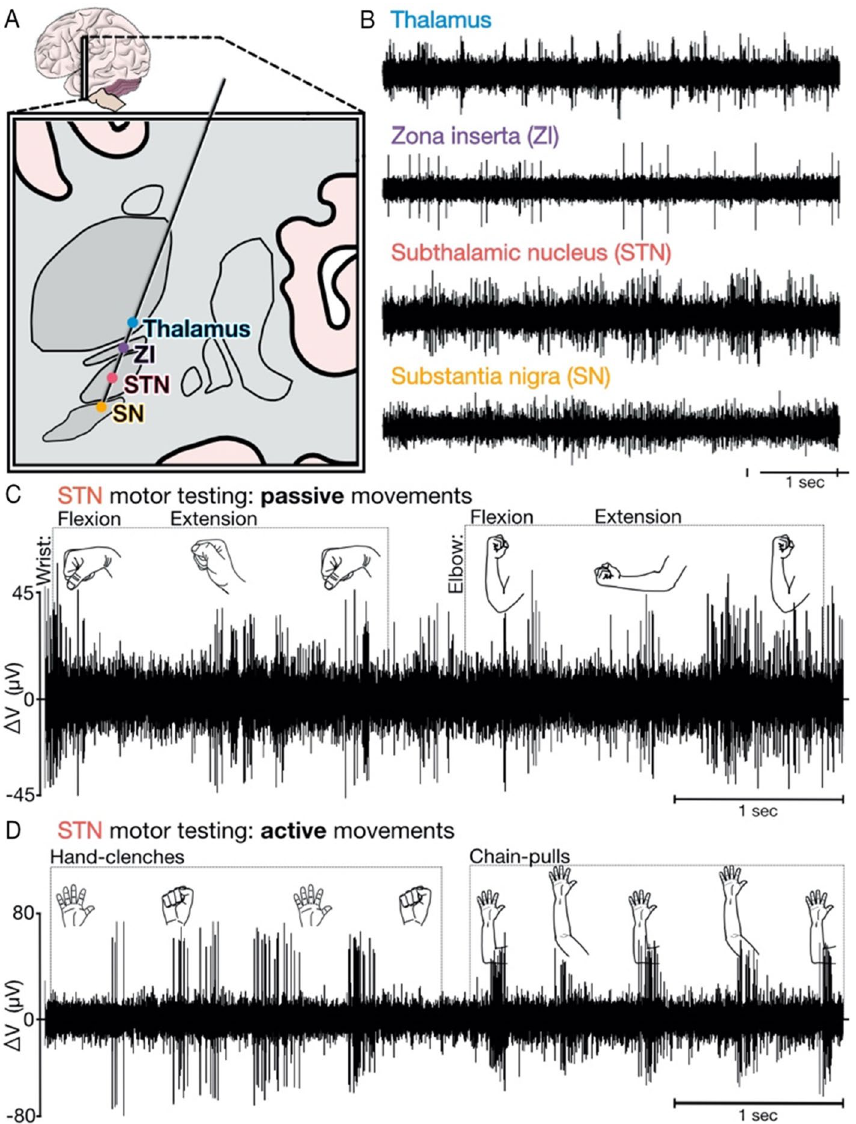
Figure 1. Microelectrode motor mapping. (A) Atlas schematic of a standard trajectory targeting the STN. ( B) Regions traversed by electrophysiological recordings demonstrate unique activity profiles used to determine the optimal location to implant the DBS electrode. ( C&D) Kinesthetic testing, both active and passive movements, aids in localizing motor regions targeted for DBS. Typically, MUA is audio-converted and clinicians listen for changes in activity while observing movements by eye. ( C) Passive movements represent clinician-driven joint manipulation. Neural activity is modulated by flexion and extension of the wrist and elbow. ( D)